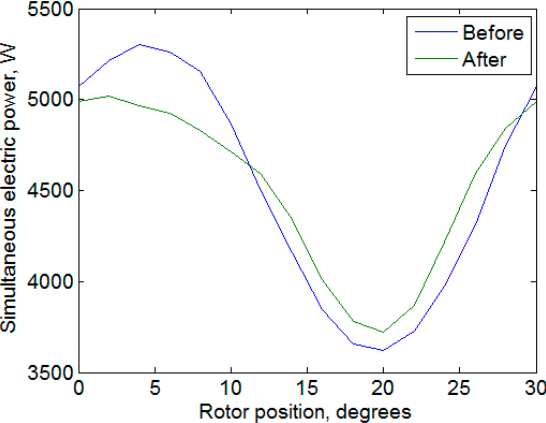
Figure 13. Comparison of power waveforms of the three-phase FRMs at rated torque and speed.